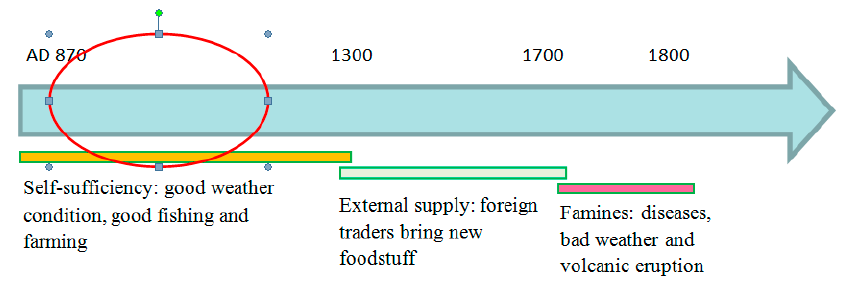
Figure 9. Timeline of Icelandic food history (adapted from Mehler 2011 [42]).